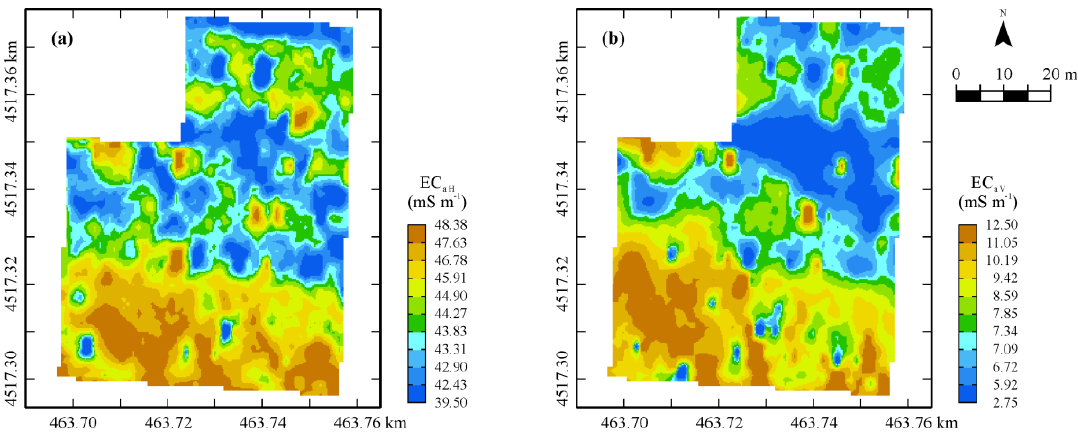
Figure 4. Maps of estimates of EC a (mS·m −1 ) in the ( a ) horizontal and ( b ) vertical orientations. Color scale uses iso-frequency classes.